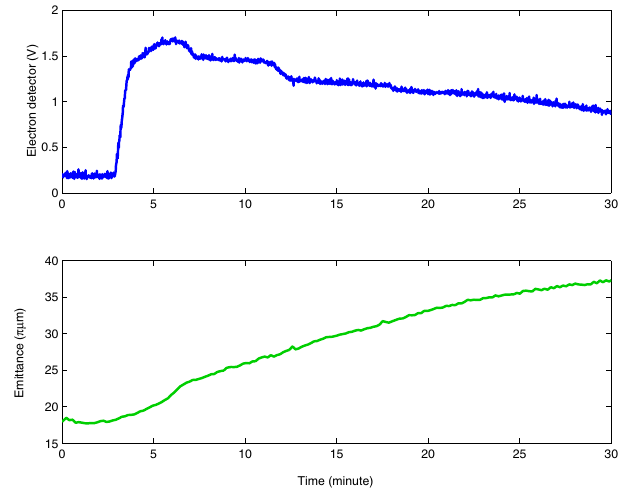
FIG. 11. (Color) Blue ring vertical beam emittance growth mea- sured by the IPM and the slow electron signal from the vertical electron detector at the Blue ring section 1 in RHIC.